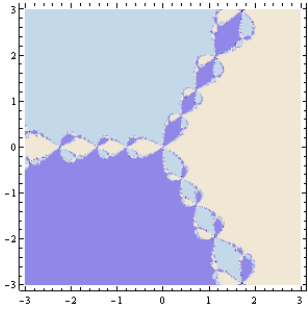
Fig. 1 Basins of attraction for the polynomial p ( z ) = z 3 − 1. Newton’s method.